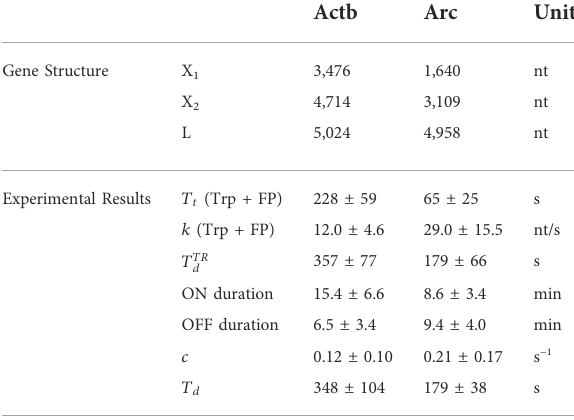
TABLE 1 Gene structure parameters and measured transcription parameters in this